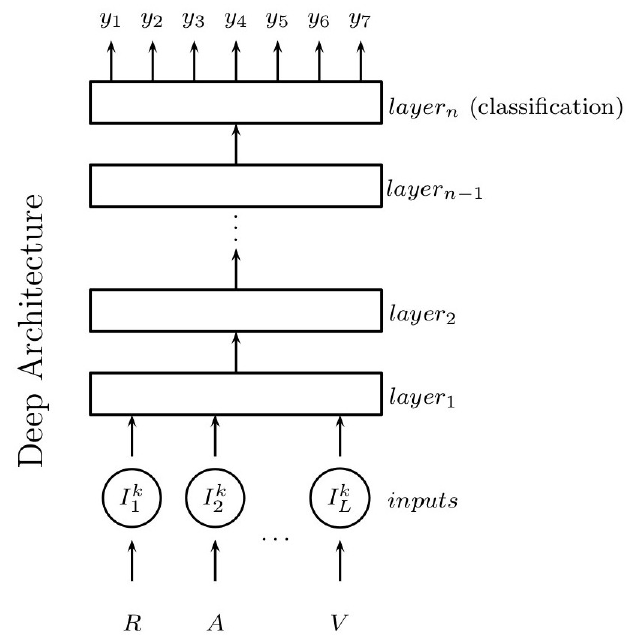
Figure 1. Deep architecture training proposal